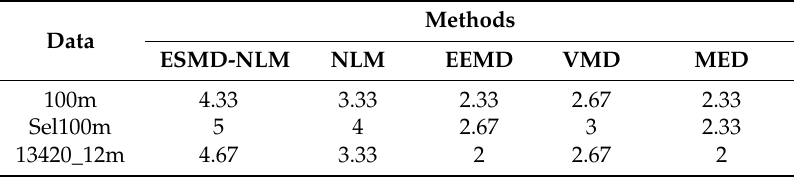
Table 3. The MOS values for the ESMD-NLM, NLM, VMD and EEMD methods operating on the three groups of clinical ECG signals.